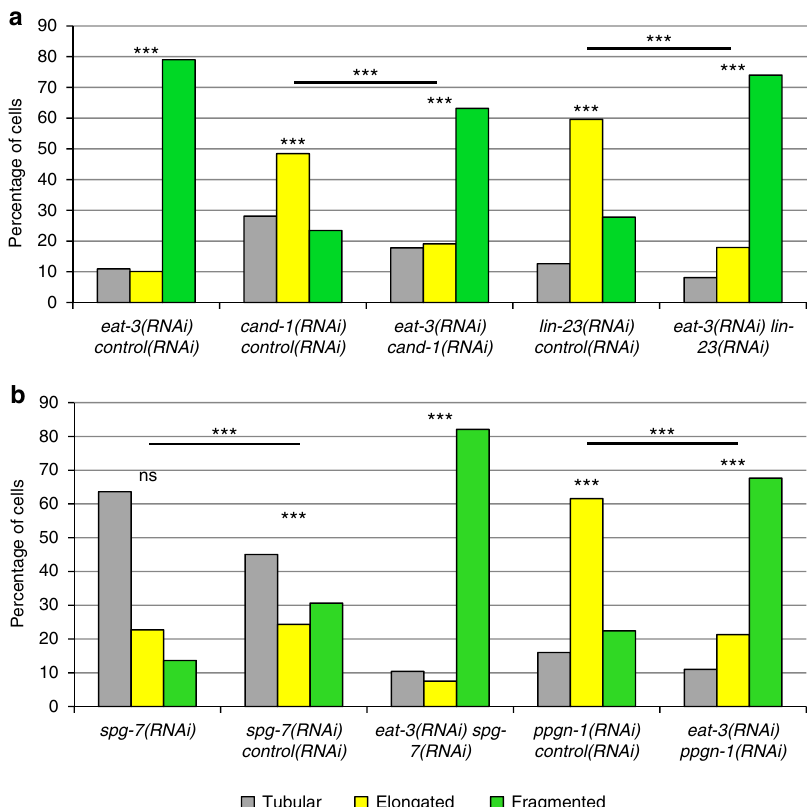
Fig. 3 Mitochondrial morphology in C. elegans body-wall muscles. a , b The percentages of muscle cells with predominantly tubular, elongated, or fragmented mitochondria in adult hermaphrodites of the indicated RNAi treatments visualized by mitochondria-targeted GFP expressed in body-wall muscle cells. P values were determined by χ 2 -test. Sample size ( n ) of muscle cells from left to right are: a 119, 128, 152, 198, 173; and b 151, 111, 173, 125, 136. Mitochondrial morphology was scored blinded. For all panels, asterisks above bars denote P value comparisons to wild type/controls; asterisks above lines denote comparisons under the lines : *** P < 0.001; ns = not signi fi